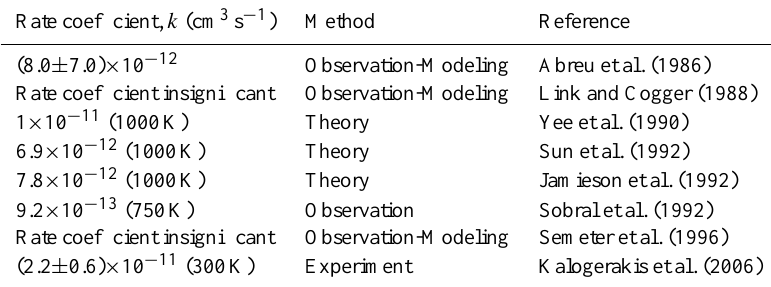
Table 1. Rate coefficients for O( 1 D) relaxation by O( 3